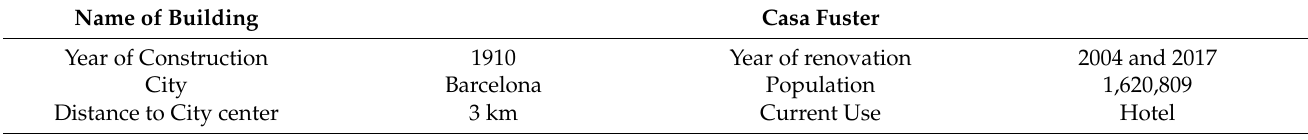
Table 1. Factsheet about the singular buildings